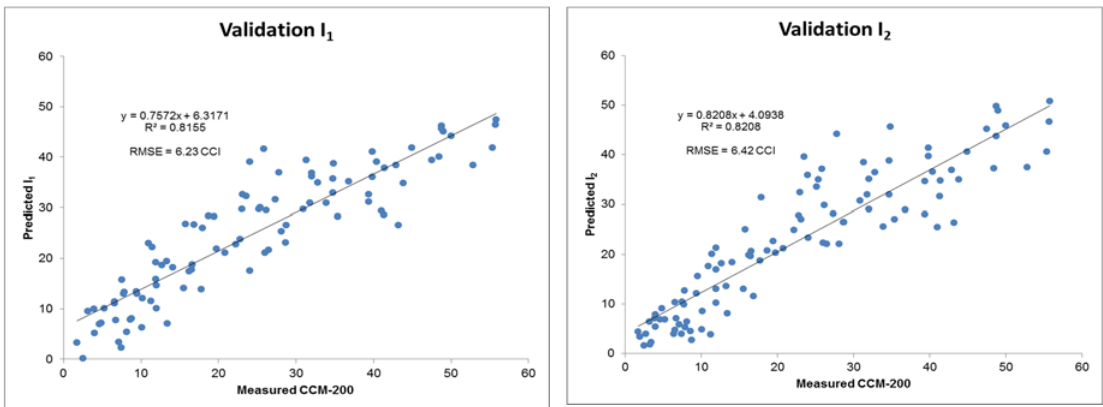
Figure 4. Comparison of chlorophyll concentration index (CCI) measured with CCM-200 chlorophyll meter vs. CCI predicted with ( left ) I 1 and ( right ) I 2 RGB indices for the validation subdataset.